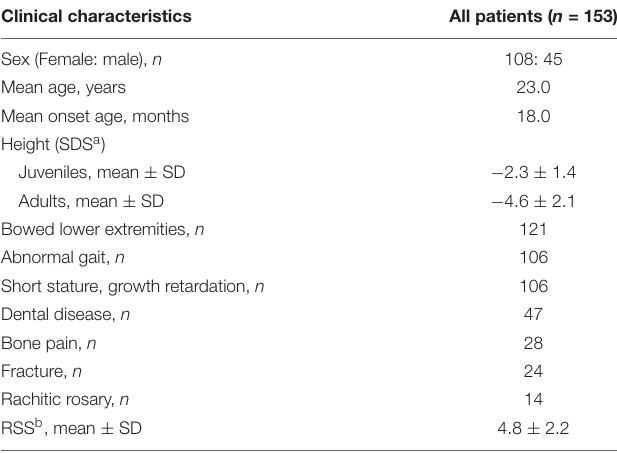
TABLE 1 | Characteristics of 153 patients with